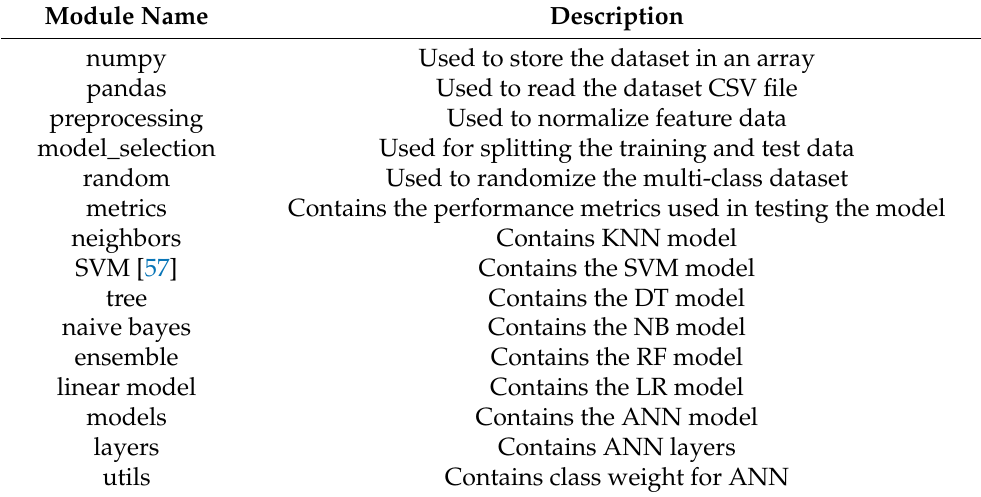
Table 7. Modules used and